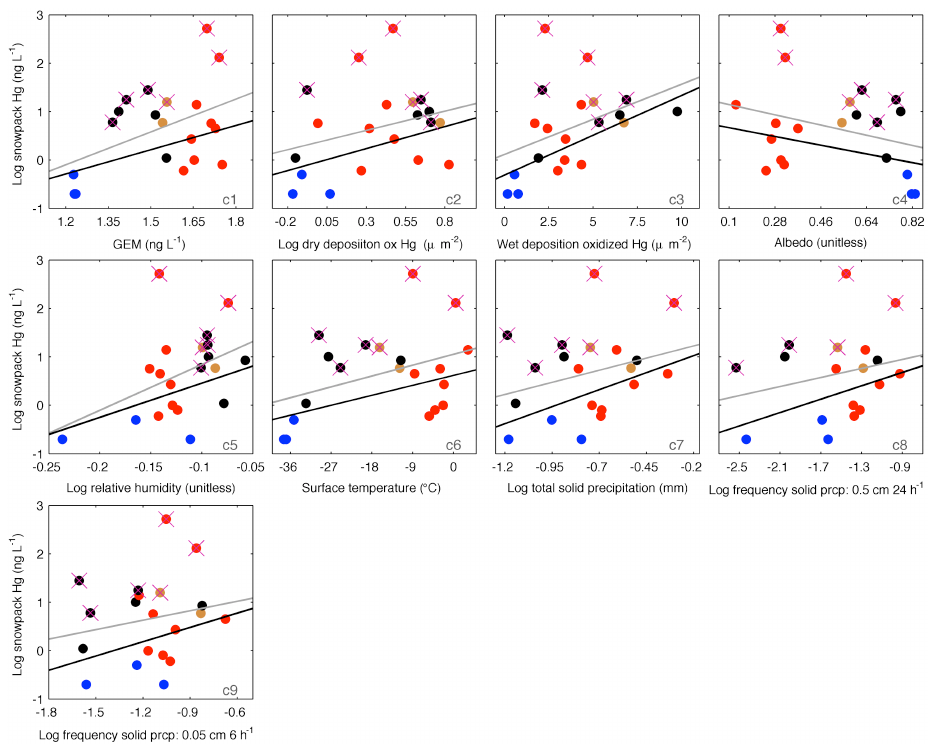
Fig. 5. Scatter plots of sufficiently strongly and significantly correlated model environmental variables with Set2’s concentration of mercury in seasonal snowpacks. Plotted as per Fig. 3.1847